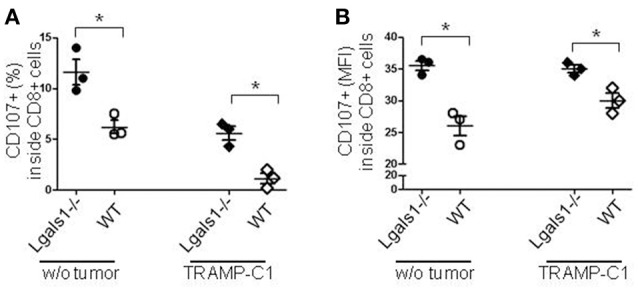
Role of endogenous Gal-1 in the degranulation capacity of CD8+ T lymphocytes. T lymphocytes from wild-type (empty circles and diamonds) or Lgals1-/- (filled circles and diamonds) mice were cultured in the presence of WT APC and 1% TRAMP-C1 tumor cells. Lymphocytes were stimulated by the CD3 receptor agonist antibody. After 48 h, the mobilization of CD107a was evaluated by flow cytometry. (A) Percentage of CD8+ T cells expressing CD107a. (B) CD107a mean intensity fluorescence (MFI) in CD8+ T cells (*p < 0.05, t-test).